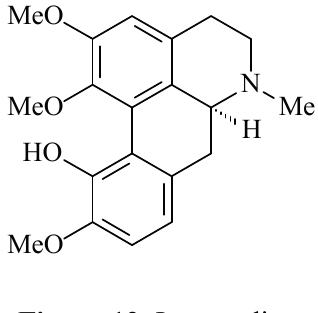
Figure 12. Isocorydine.